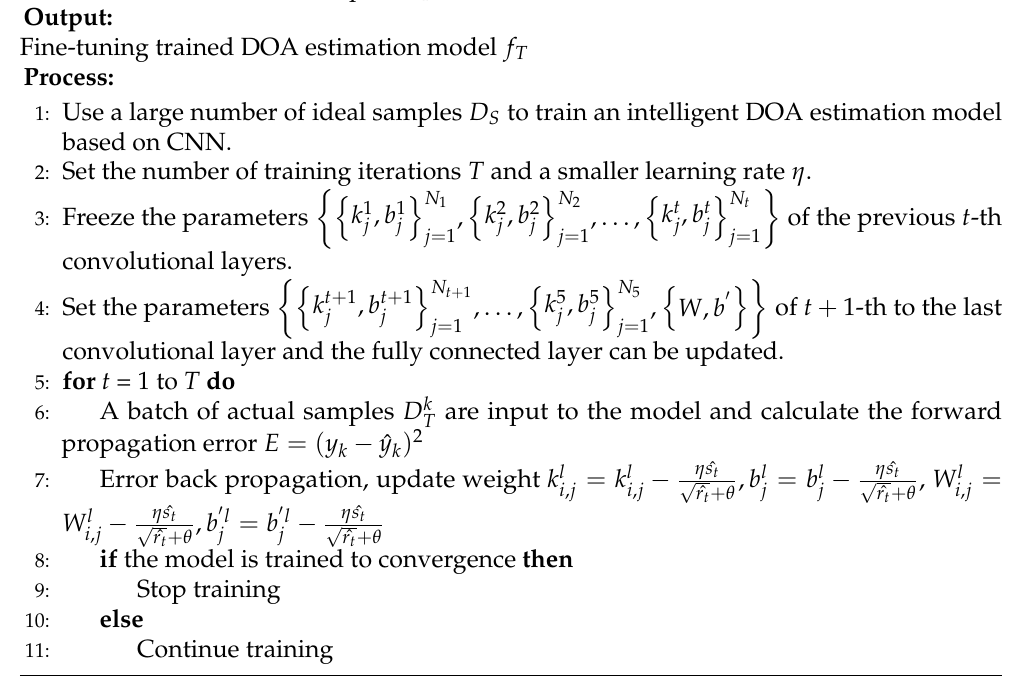
Algorithm 1 Error calibration method based on transfer